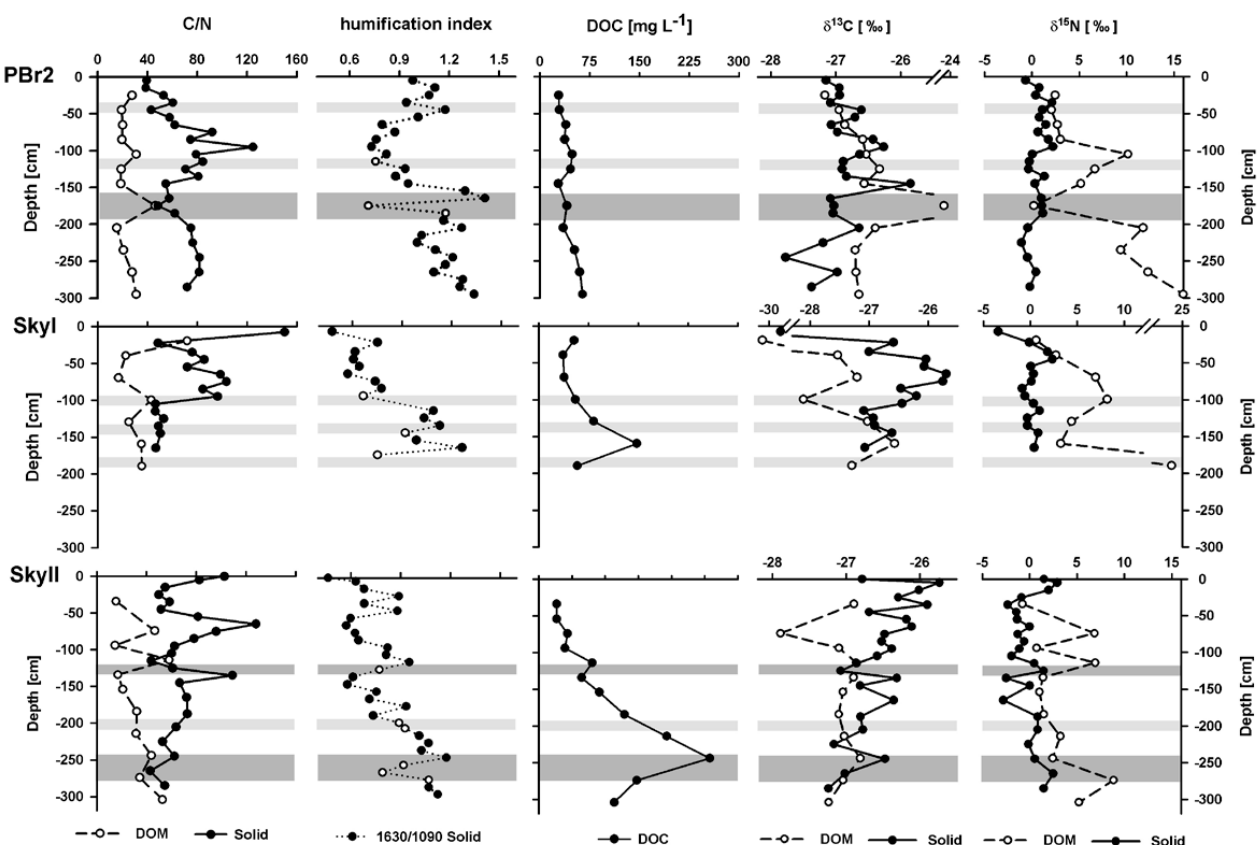
Fig. 4. C/N ratios of solid peat and DOM, FTIR derived humification indices (ratios of absorption at wavenumbers 1630/1090), DOC concentrations, δ 13 C and δ 15 N of solid peat and DOM at the sites PBr2 (top), SkyI (middle), and SkyII (bottom). Grey bands denote ash layers. Open symbols in profiles of humification indices indicate samples possibly influenced by ash deposits and need to be interpreted with